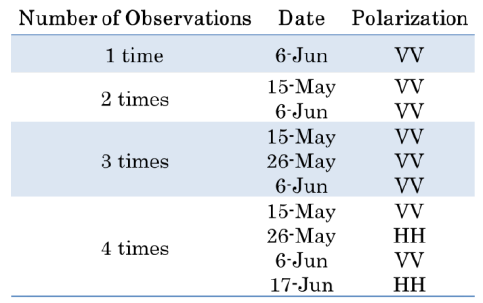
Table 2. Selected dates and polarizations